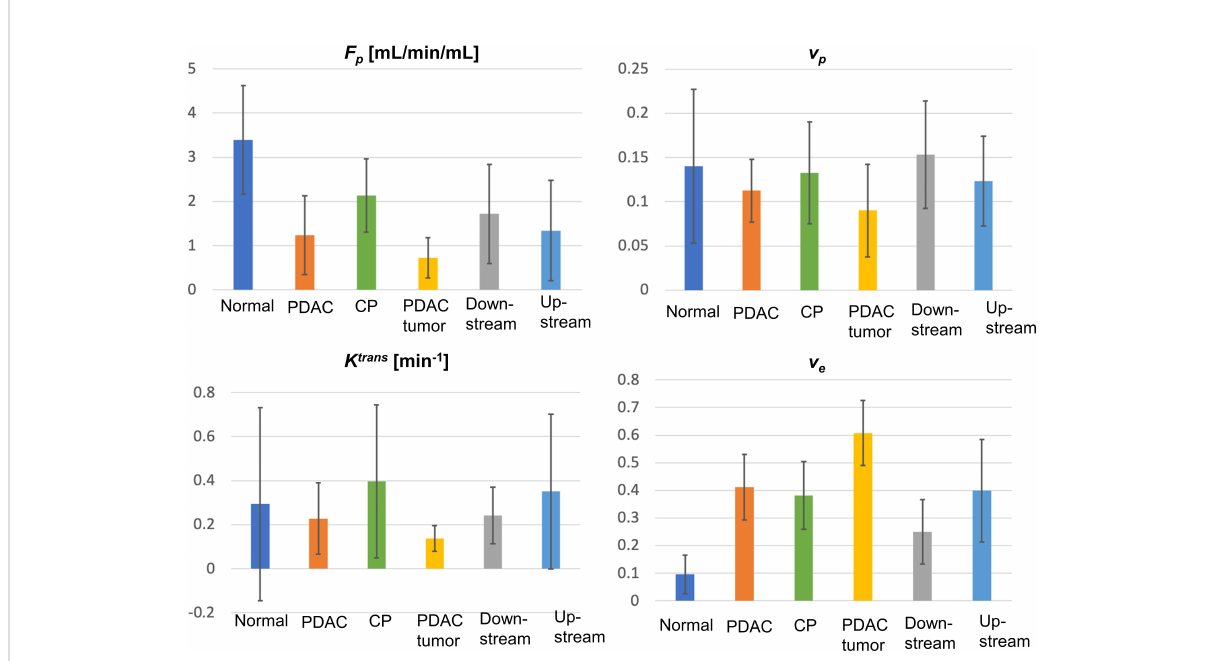
FIGURE 3 Bar graphs for the mean and standard deviation (error bar on top of each bar) for F p , v p , K trans , and v e for all types of tissues (normal, normal control pancreas; PDAC, PDAC pancreas; CP, CP pancreas).